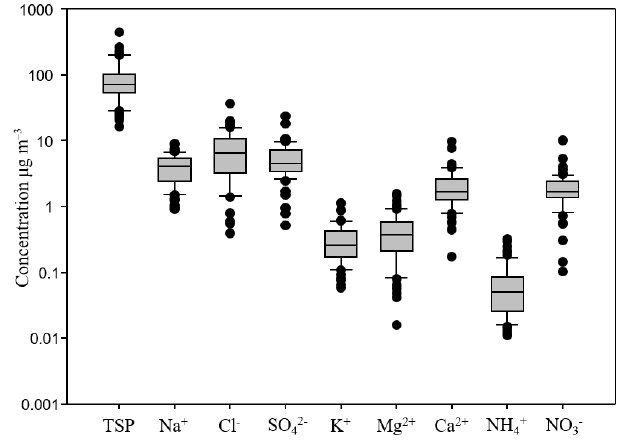
Figure 3. Annual average mass concentrations of aerosol chemical species at Yongxing Island. Box boundary indicates 25th and 75th percentile. Lines within the box show the mean. Whiskers above and below the box indicate 90th and 10th